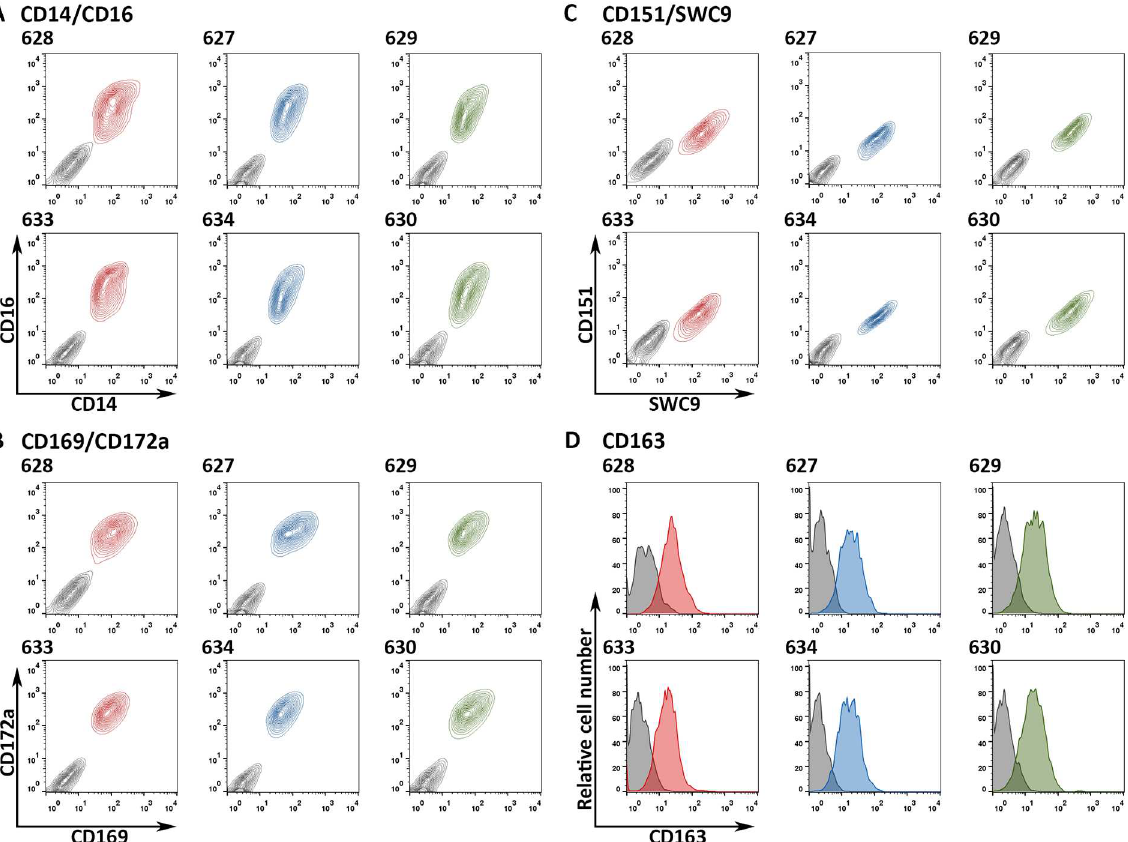
Fig 4. Δ SRCR5 peripheral blood monocyte-derived macrophages (PMMs) are fully differentiated and express macrophage- specific markers. Peripheral blood monocyteswere isolatedfrom the bloodof the wild type (red), heterozygous (blue), and Δ SRCR5 (green)animals. Followingcultivationin the presenceof recombinant human CSF1 (rhCSF1) for seven days PMMs were analyzed by FACS. A) Co-staining with CD14-FITC and CD16-PEantibodiesrecognizingthe native structure of the proteins (coloredcontour plots; red wild type, blue heterozygous, green Δ SRCR5) relative to isotype controls (grey). B) Co-staining with CD169-FITC and CD172a-PE antibodies recognizing the native structure of the proteins (coloredcontour plots) relative to isotype controls (grey). C) Co-staining with SWC9 (CD203a)-FITC and CD151-RPE antibodiesrecognizing the native structure of the proteins (coloredcontour plots) relative to isotype controls (grey). D) Stainingagainstthe native structure of surface expressedCD163(colored)relative to an isotype control staining